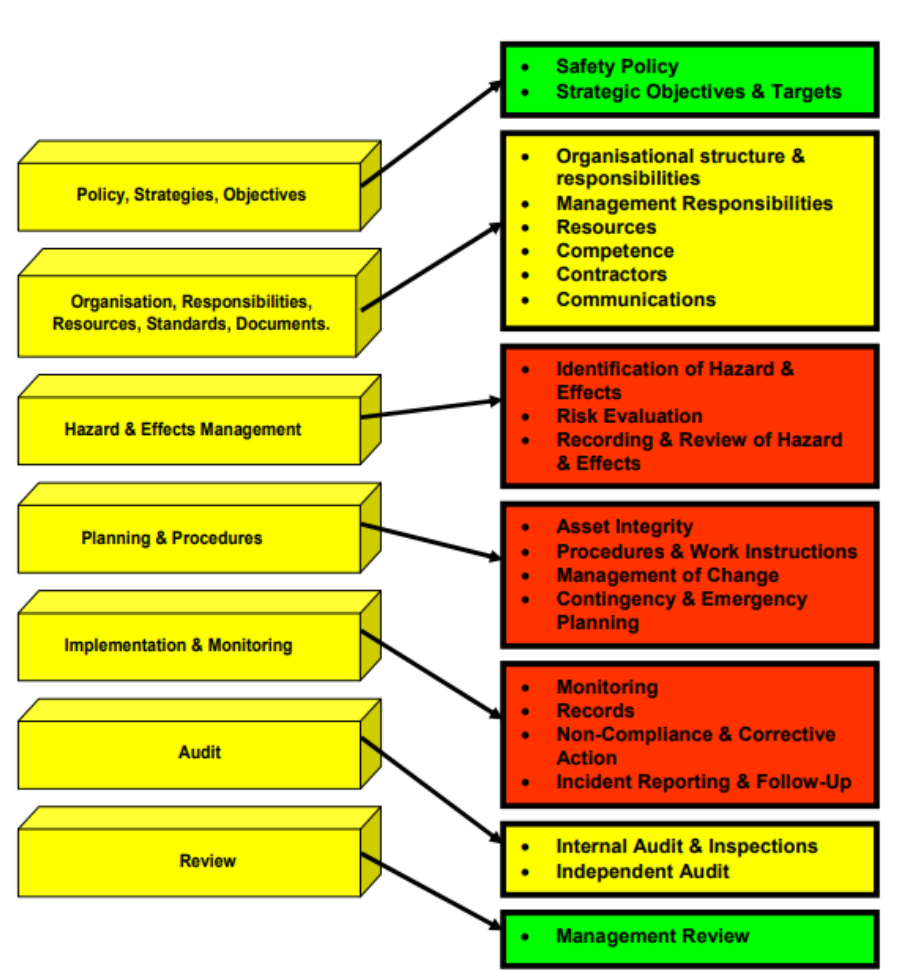
Figure 12. Elements of a management system that is capable of managing aging plant issues (This image is re-used/reproduced with permission of the Health and Safety Executive under the terms of the Open Government License, Courtesy: HSE, UK. Source: [224]).